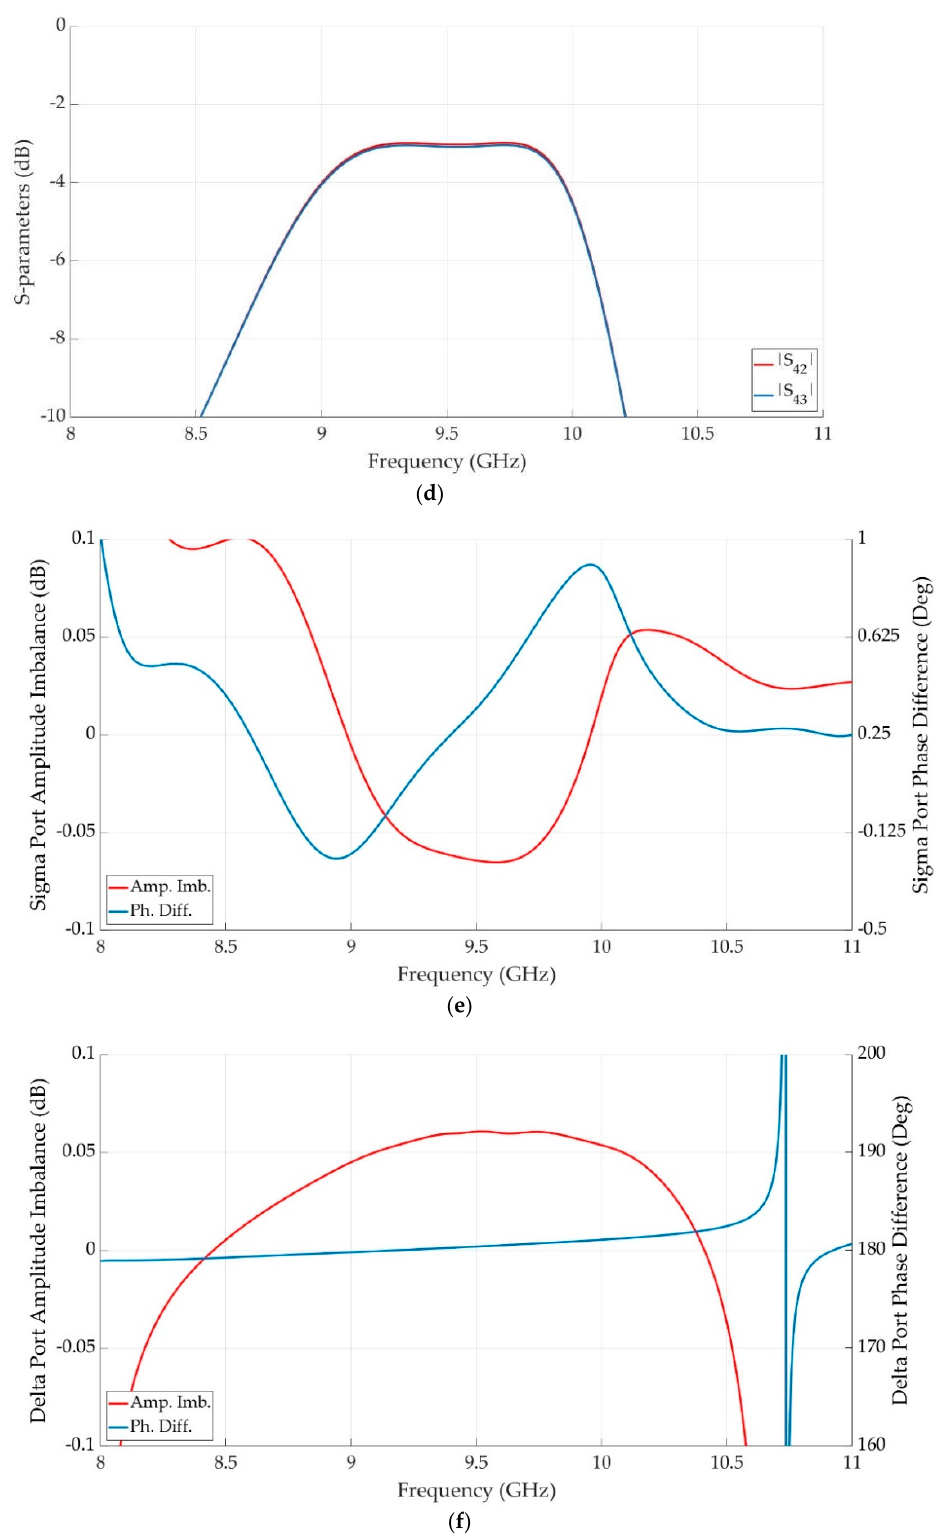
Figure 11. XMT simulated scattering parameters. ( a ) Port matching. ( b ) Port isolation. ( c ) Transmission coefficients (sum port excited). ( d ) Transmission coefficients (difference port excited). ( e ) Amplitude imbalance and phase difference (sum port excited). ( f ) Amplitude imbalance and phase difference (difference port excited).